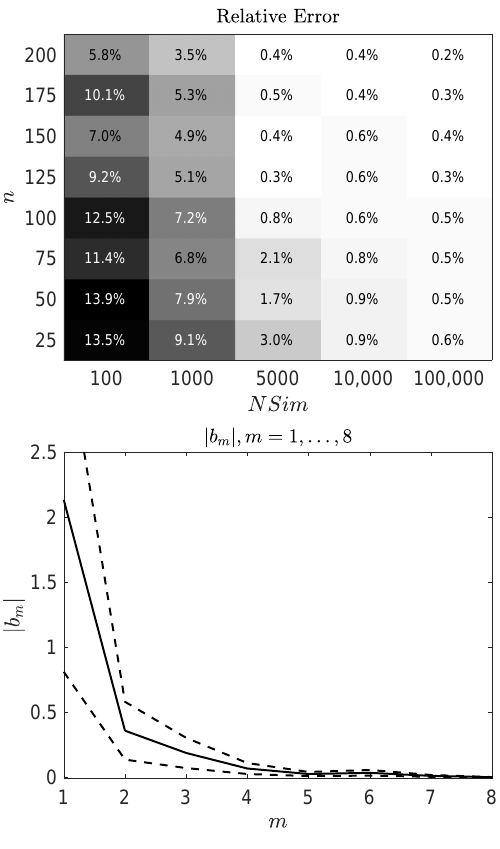
Figure 1. ( Top panel ): Relative pricing errors with respect to the binomial tree of an American call option in the standard Black–Scholes–Merton model with S 0 = 100, K / S 0 = 105, r = 3%, q = 4%, T = 1, m = 6; the darker the cell, the higher the relative error; ( Bottom panel ): absolute value of the average of the first 8 betas of the regression in Equation (6) for the evaluation of the previous American call option. Twenty independent Monte Carlo (MC henceforth) simulations were